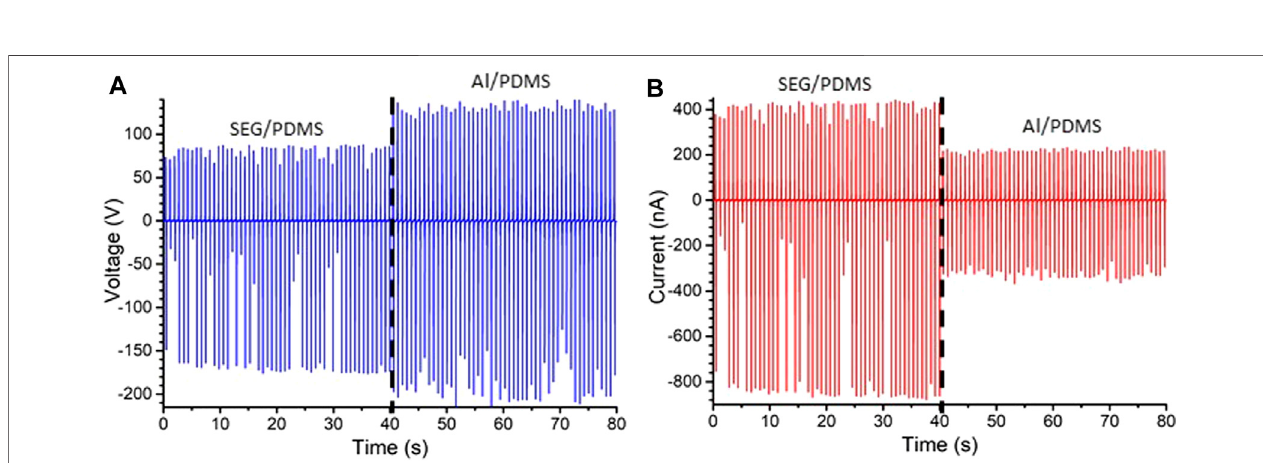
FIGURE 6 | Output values comparison for both tested devices on the calculated maximum power point of operation, showing the difference in voltage (A) and current (B) values.